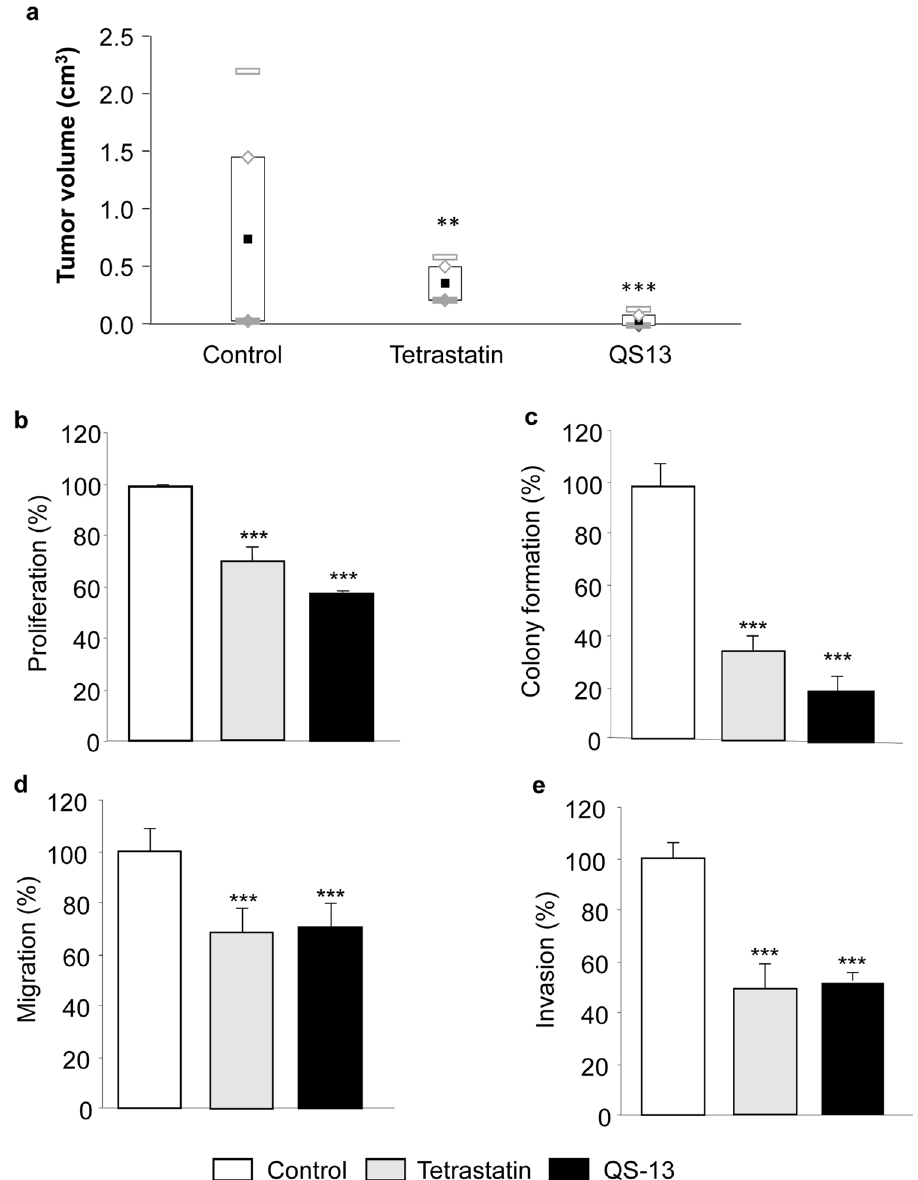
Figure 1. QS-13 peptide inhibits in vivo tumor growth, in vitro SK-MEL-28 melanoma cell proliferation, colony formation, migration and invasion. Tumor growth was measured at day 20 in a mouse melanoma model ( a ). Cell proliferation was measured after 72 h of incubation ( b ). Colony formation in soft agar was measured after 10 days of incubation ( c ). Cell migration in scratch wound assay was measured after 48 h of incubation. ( d ) Cell invasion through Matrigel-coated membranes was measured after 48 h of incubation ( e ) ** p < 0.01, *** p <